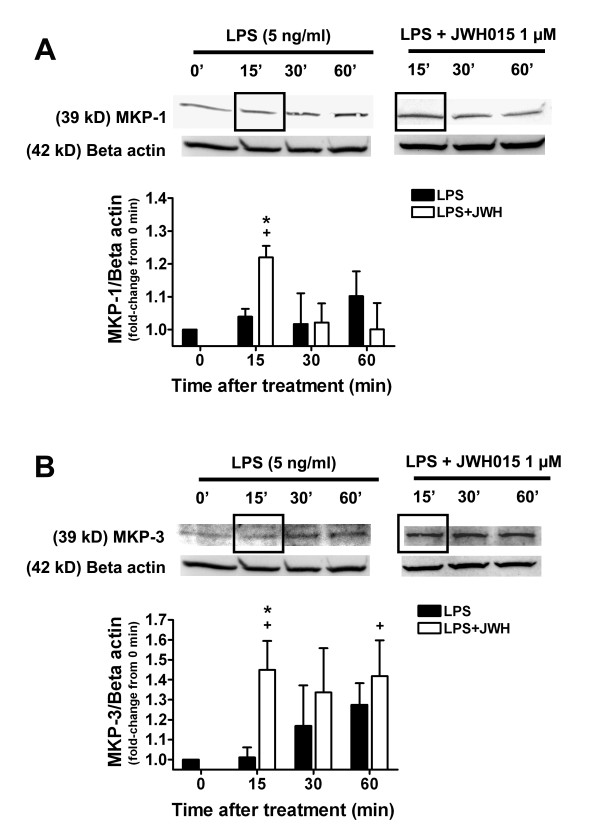
Effects of microglial CBR2 activation on the MKP-1/3 pathway. Representative western blots and quantification of MKP-1 (A) and MKP-3 expression (B) at different incubation time points (15–60 min, 0 = medium control group) in LPS-stimulated microglia in the presence or absence of JWH015 (1 μM). JWH015 produced a MKP-1 and MKP-3 increase (15 min). +p < 0.05 vs. medium control group; *p < 0.05 vs. LPS alone group.